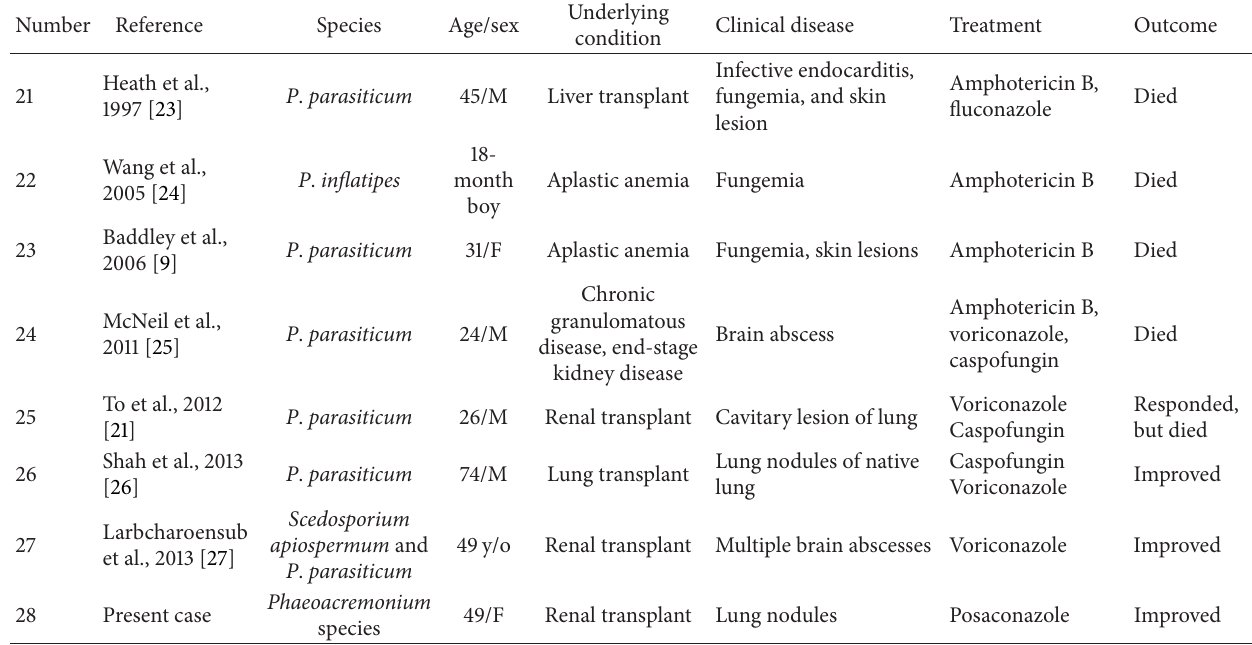
Table 2: Invasive and disseminated infections due to Phaeoacremonium